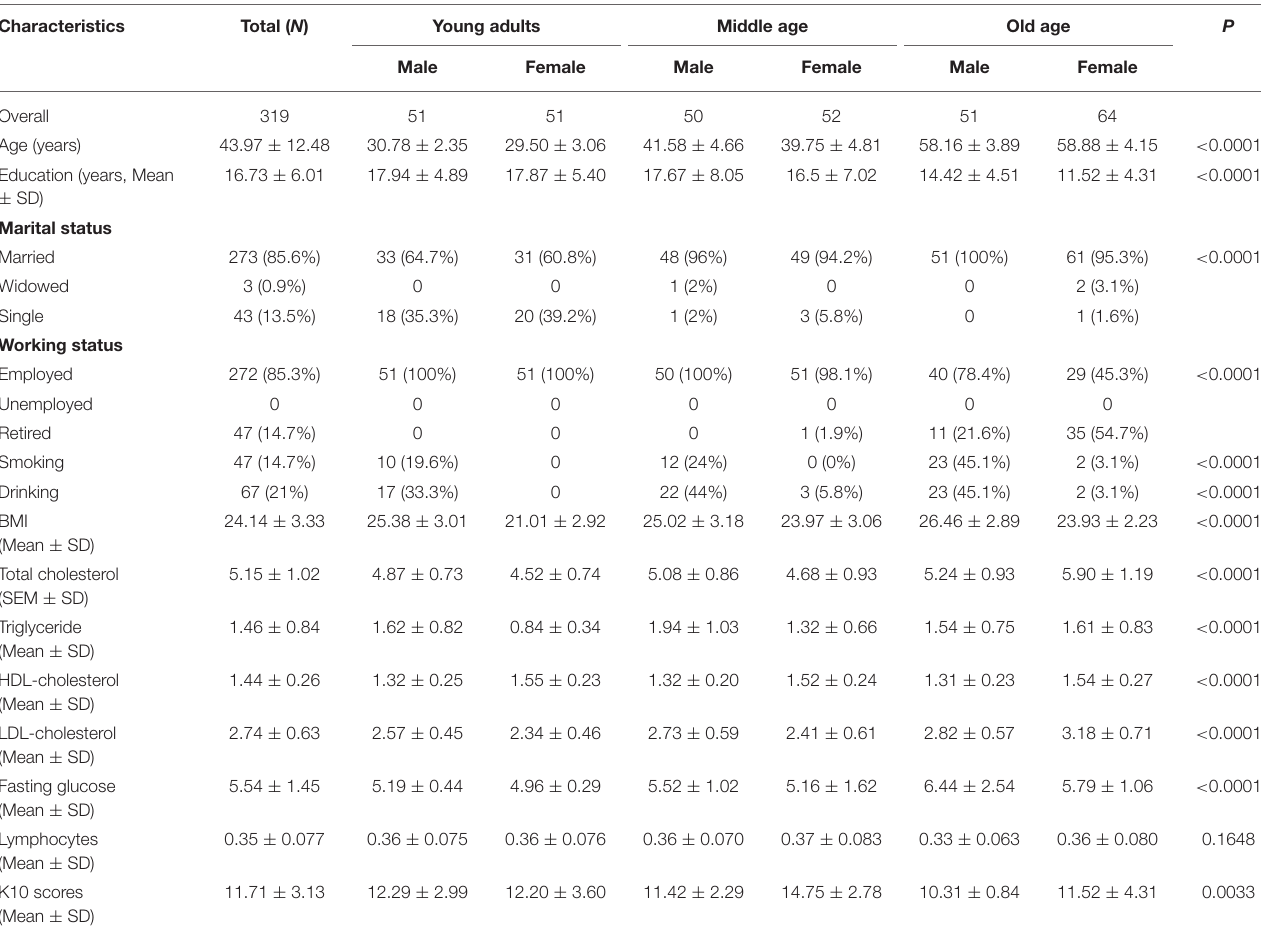
TABLE 1 | Sociodemographic data, BMI, metabolic characteristics, and K10 scores of the sample.